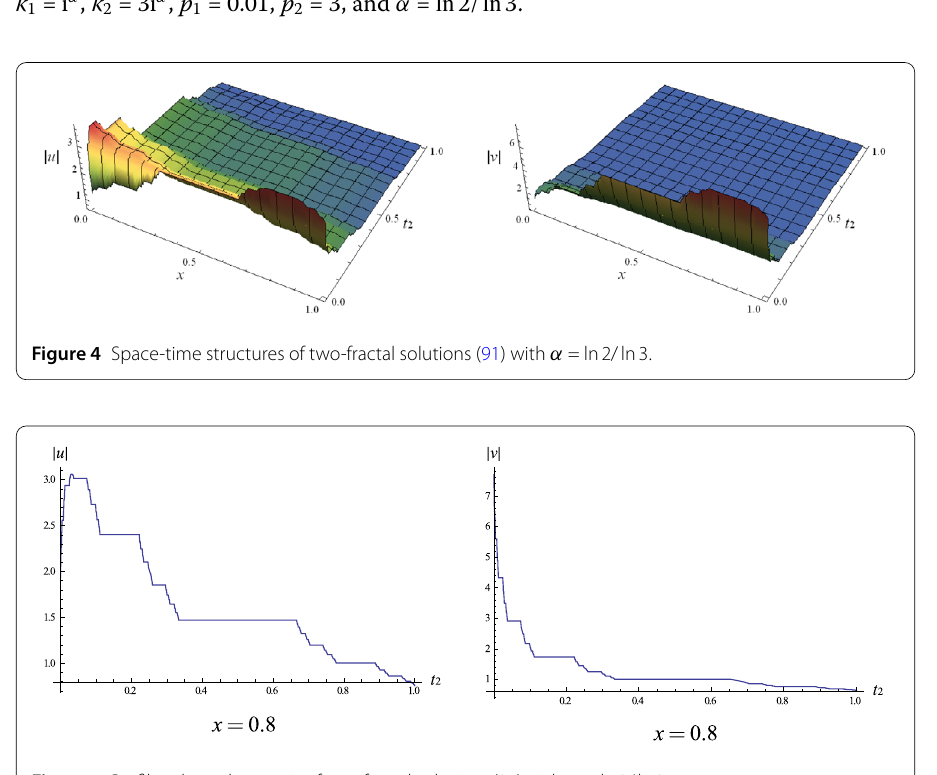
Figure 5 Profiles along the t 2 axis of one-fractal solutions (91) with α =